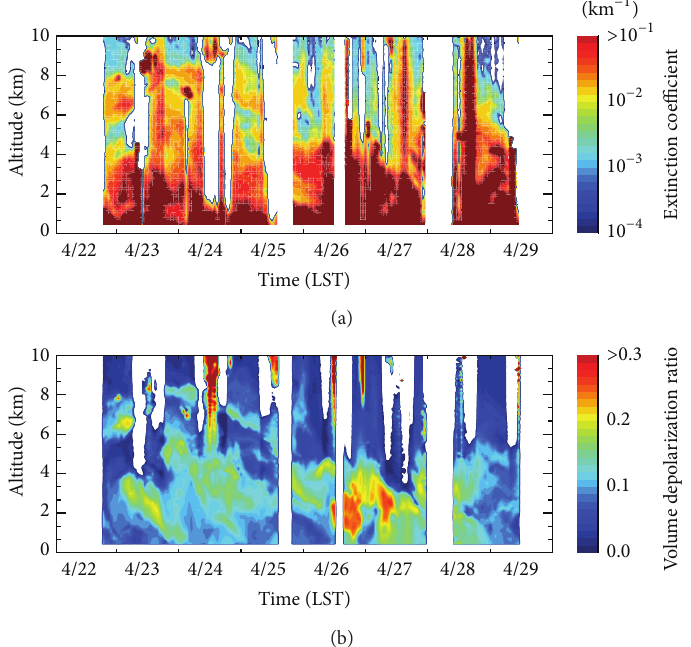
Figure 2: Temporal variation in the extinction coefficient (a) and volume depolarization ratio (b) at 532 nm. These data were obtained using the depolarization lidar on 22–29 April 2011 over